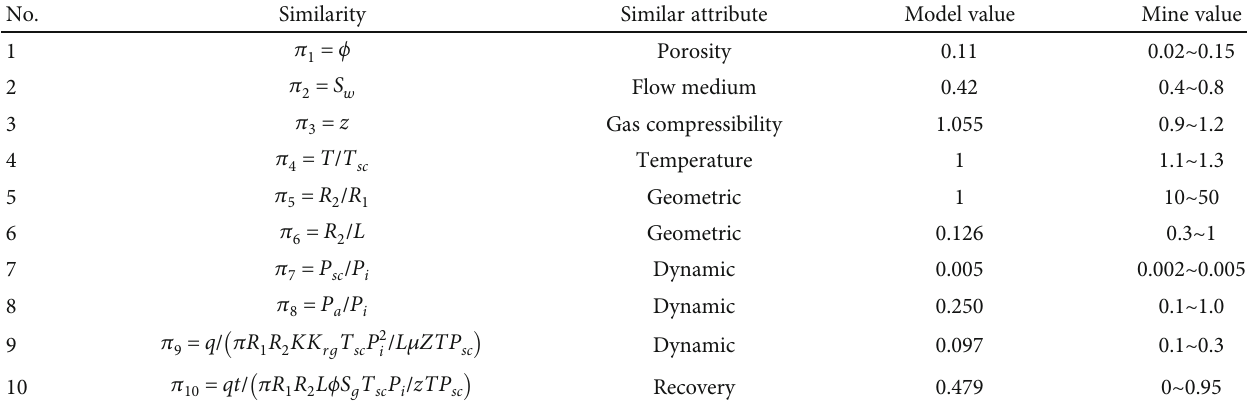
Table 4: Physical simulation similarity of the tight sandstone gas reservoir